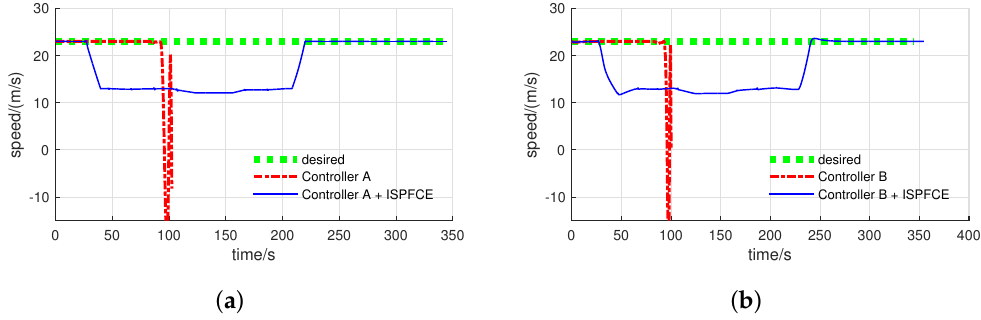
Figure 23. Speeds of vehicles controlled by different controllers: ( a ) Controller A and ( b ) Controller